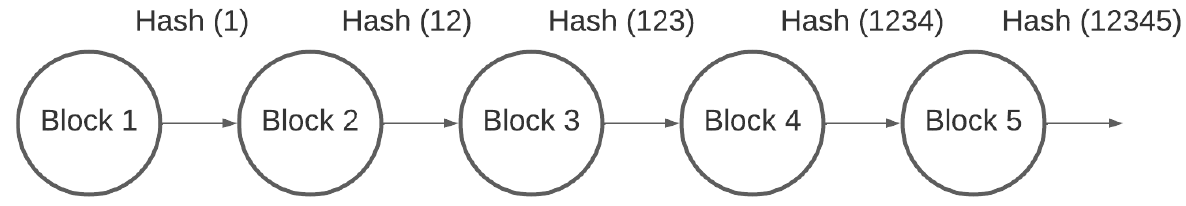
Figure 9. Merkle tree of blocks in the blockchain.